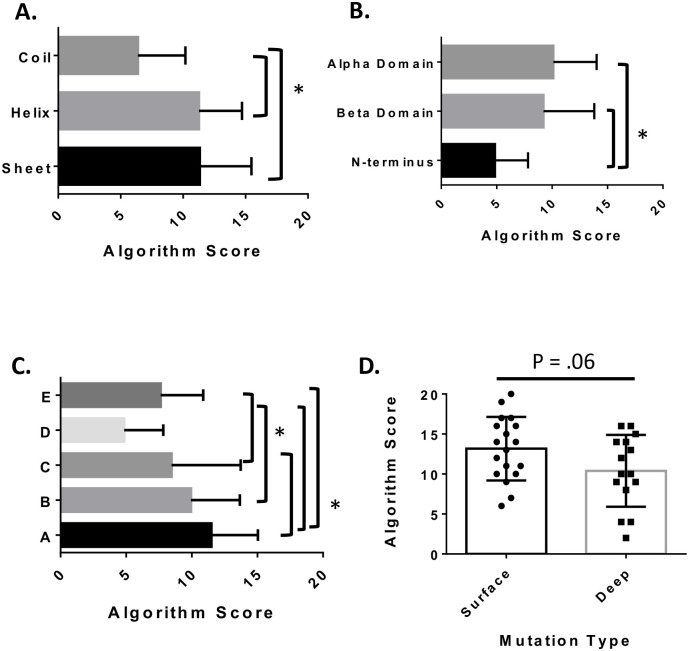
Association of missense mutation algorithm score to its spatial distribution on pVHL.A. Algorithm scores for mutations according to secondary structure. B. pVHL domain C. or pVHL binding interfaces. Significance was determined using an ANOVA or Kruskal-Wallis test and followed up with Tukey HSD or Dunn’s MCT as appropriate. Error bars represent the standard deviation. * represents a significant difference with a p < .05. D. Algorithm Score for mutations according to their depth within the structure of VHL. Each dot is a mutation. Error bars represent the standard deviation. * represents a significant difference with a p < .05 as determined by Student’s t-test. All statistics were done using GraphPad Prizm.